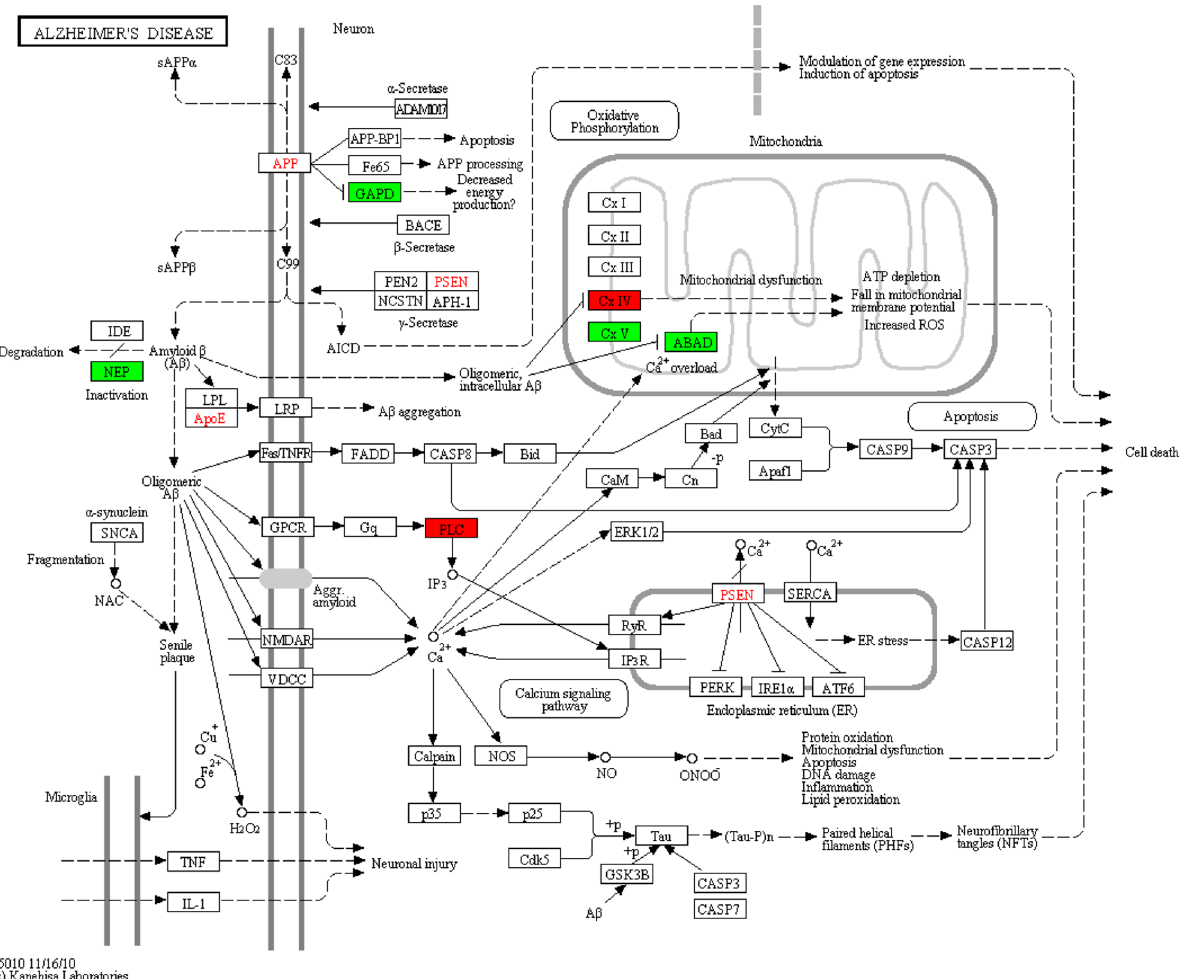
Figure 3. Distribution of differential genes in Alzheimer disease pathway. Through KEGG annotation analysis, we found 7 genes related to the Alzheimer disease pathway. There are 4 core factors in Alzheimer disease, which are APP, PSEN, ApoE, and Tau, shown in red font. The seven genes enriched were Lpl (LPL), Mapt (Tau), Mme (NEP), Ndufa3 (Cx I), Lrp1 (LRP), Gapdh (GAPD), and mt-Co3 (Cx IV). Green boxes indicate down- regulation of related genes, and red indicates